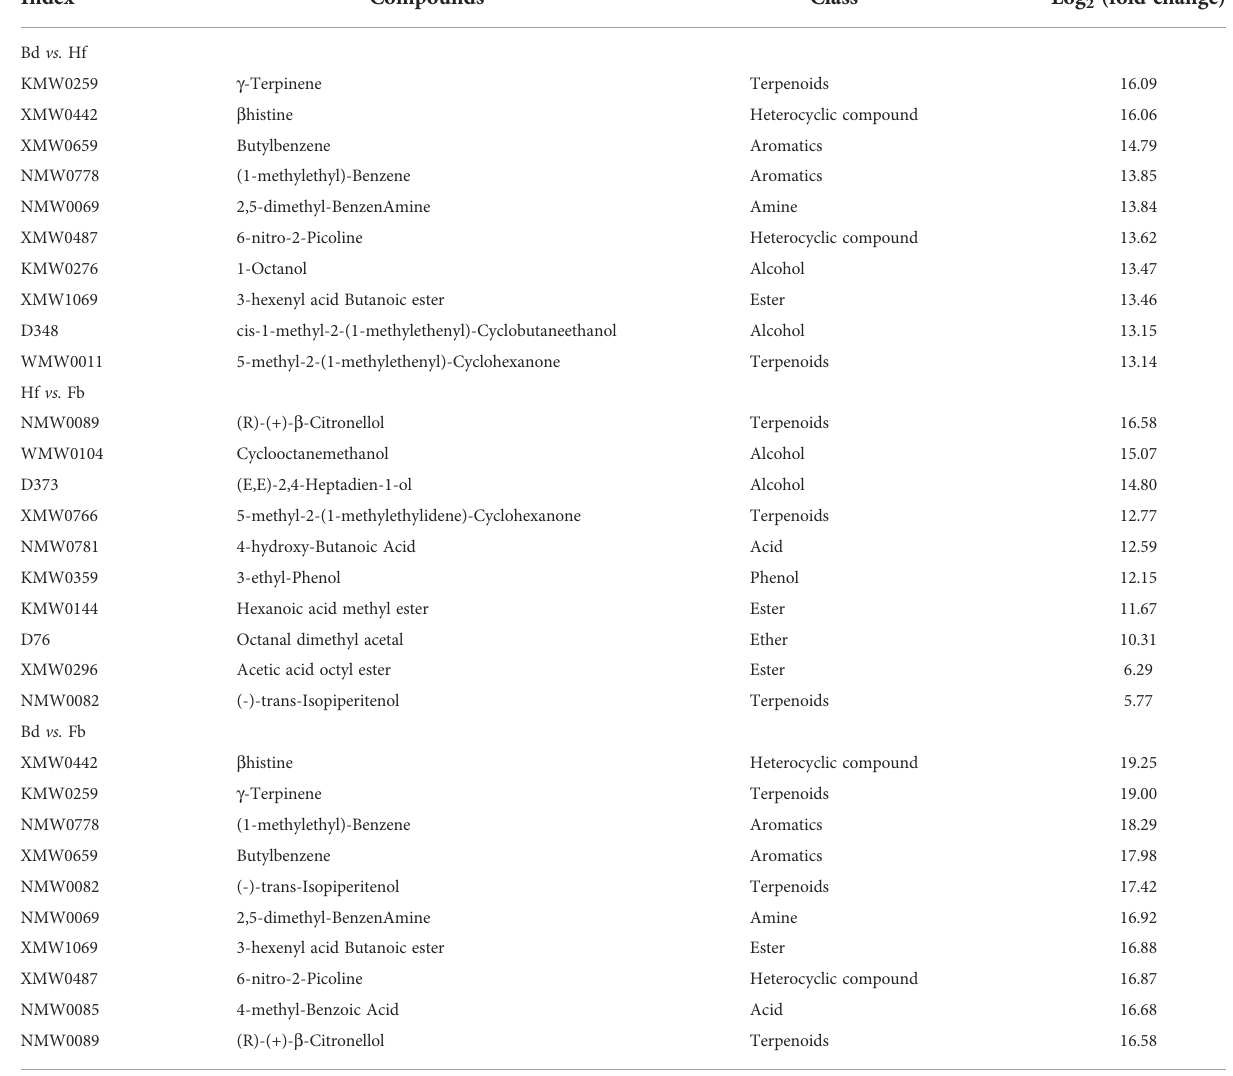
TABLE 1 Top 10 DVOCs with fold change in each comparison of